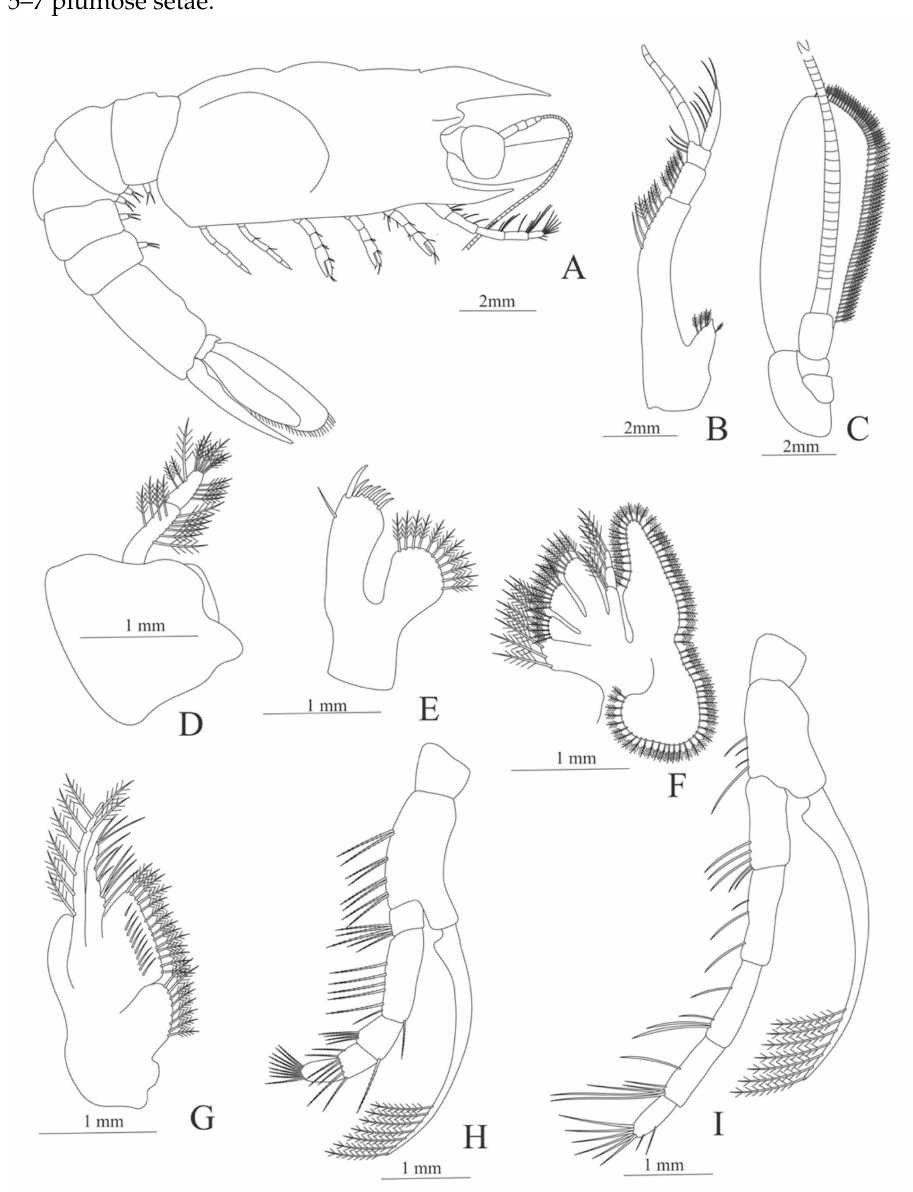
Figure 27. Hemipenaeus carpenteri : ( A ) lateral view; ( B ) antennule; ( C ) antenna; ( D ) mandible; ( E ) maxillule; ( F ) maxilla; ( G ) first maxilliped; ( H ) second maxilliped; ( I ) third